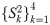
2-dim Euclidean distances of clusters {Sk2}k=14.